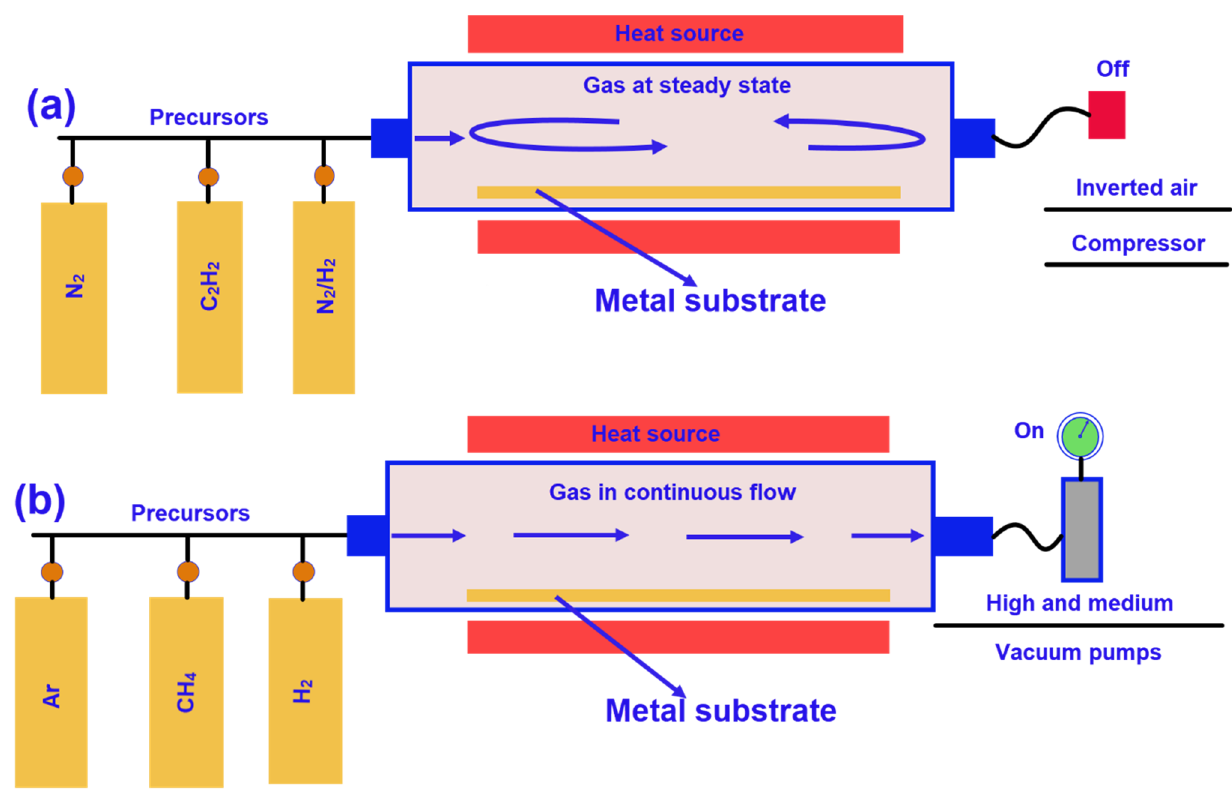
Figure 10. Schematic representation of the chemical vapour deposition of graphene synthesis ( a ) at atmosphere pressure using polycrystalline substrate and gas discontinuous flow, ( b ) at high vacuum using monocrystalline substrate and gas continuous flow; Reprinted with permission from [190].